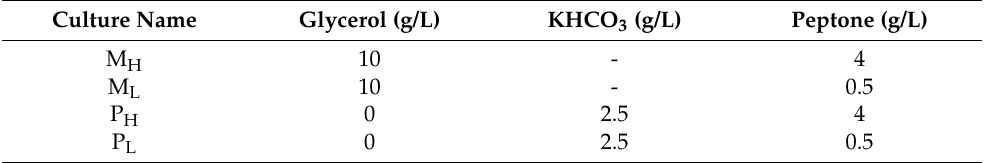
Table 4. Basic experimental design of A. protothecoides grown mixotrophically or photoauthotrophi- cally under different light qualities. (M H and M L stands for mixotrophy with high and low peptone, respectively and P H and P L stands for photoautotrophy with high and low peptone, respectively). Culture Name Glycerol (g/L) KHCO 3 (g/L) Peptone